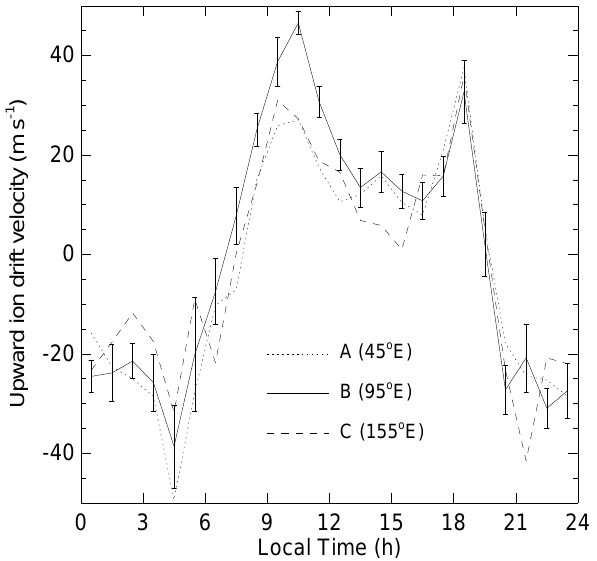
Fig. 4. The mean vertical E × B drift patterns at the three longi- tudes obtained from ROCSAT-1. The mean velocity at each local time was calculated using data within ± 5 ◦ magnetic latitudes dur- ing equinox in 1999–2002.